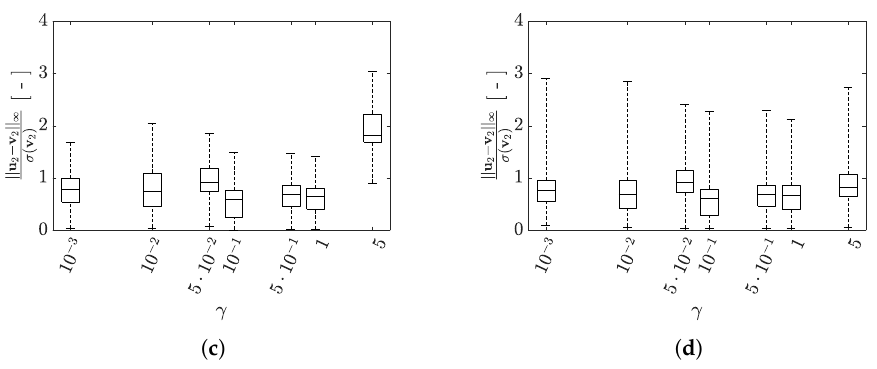
Figure 20. Two-storey shear building, configuration A. Effect of γ on the statistics of the reconstruction errors relevant to the floor displacement v 2 , represented through box plots: ( top row ) standardized L 2 norm, and ( bottom row ) standardized L ∞ norm; data taken from ( left column ) training set, and ( right column ) test